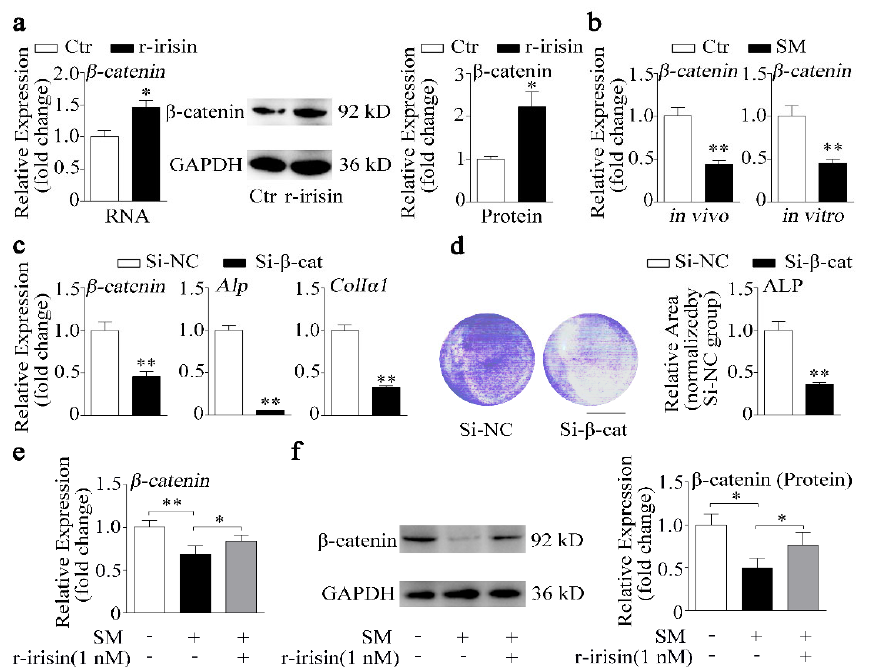
Figure 5. r-Irisin promotes β -catenin expression to regulate osteoblast di ff erentiation under simulated microgravity condition. ( a ) Real-time PCR and Western blot analysis of β -catenin and quantification of β -catenin protein level in primary osteoblasts after treatment with either 1 nM r-irisin or PBS for 48 h; n = 3. ( b ) Real-time PCR analysis of β -catenin expression in tibias of control and hind-limb unloading mice for 28 days in vivo ( n = 4) or in primary osteoblasts after random position machine for 48 h in vitro ( n = 3). ( c ) Real-time PCR analysis of β -catenin , Alp , and ColI α 1 expressions in MC3T3-E1 cells after treatment with either β -catenin small interfering RNA (siRNA) (Si- β -cat) or siRNA negative control (NC) (Si-NC) for 48 h; n = 3. ( d ) Representative images of ALP staining and quantification of staining areas in MC3T3-E1 cells after treatment with either Si- β -cat or Si-NC for 48 h. Scale bar, 5 mm; n = 3. ( e ) Real-time PCR analysis of β -catenin in primary osteoblasts after treatment with either 1 nM r-irisin or PBS for 48 h under simulated microgravity; n = 3. ( f ) Western blot analysis and quantification of β -catenin protein level in primary osteoblasts after treatment with either 1 nM r-irisin or PBS for 48 h under simulated microgravity; n = 3. Gapdh was used as the internal control for mRNA. Ctr: